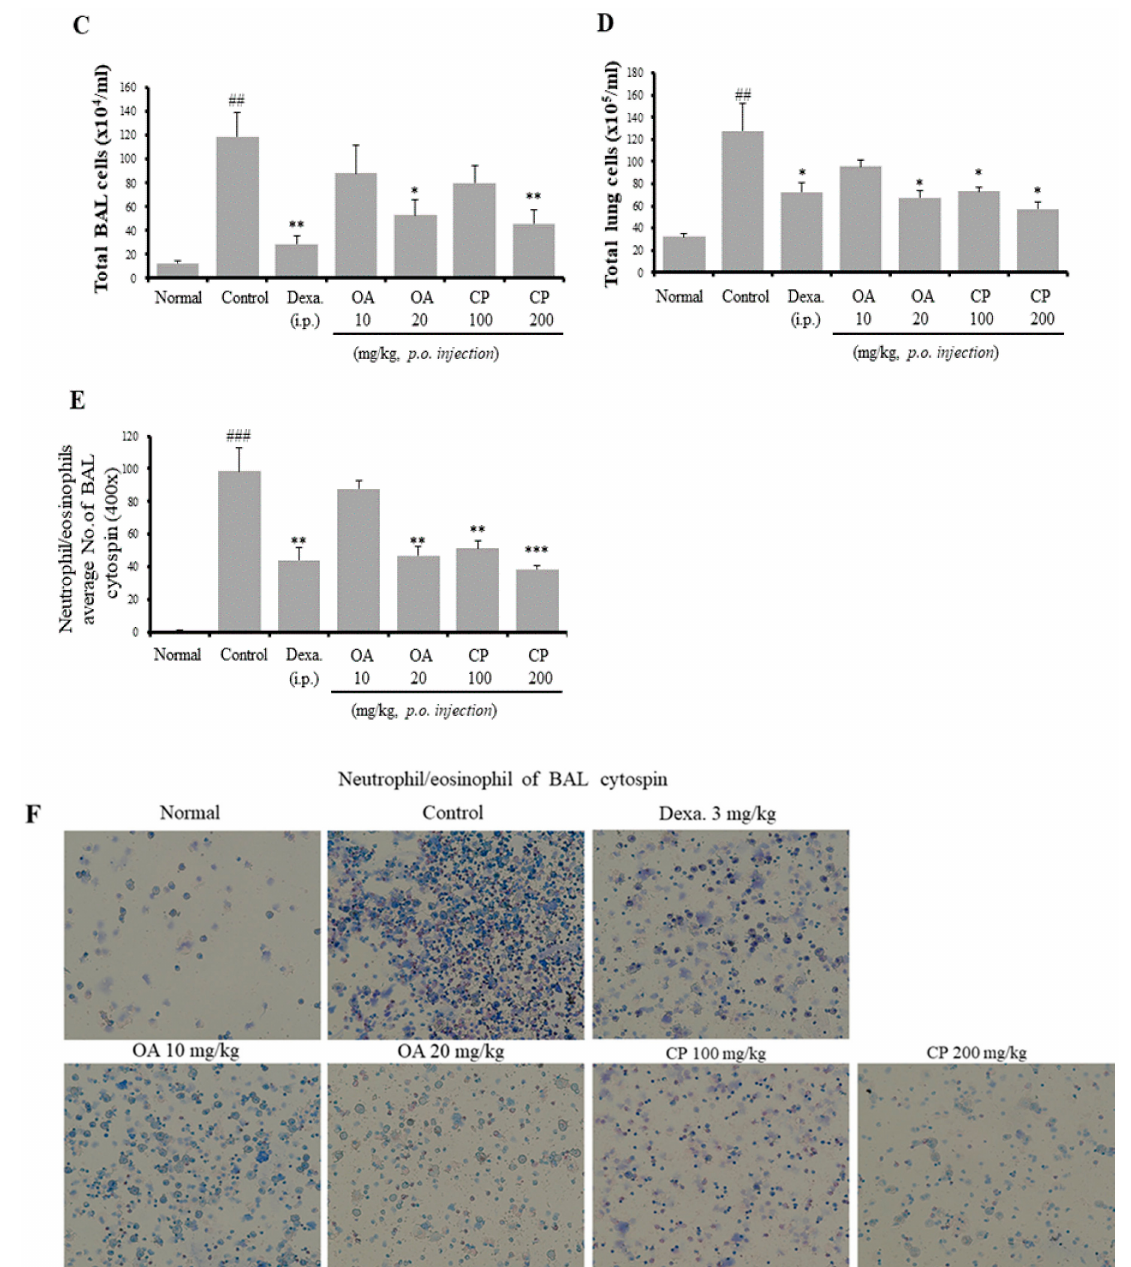
Figure 1. Schematic protocol illustration of ovalbumin (OVA)-induced mouse model of asthma ( A ). The suppressive effects of Cicadae Periostracum (CP) on airway hyperresponsiveness (AHR) in OVA-challenged mice were measured as enhanced pause (Penh) using non-invasive whole-body plethysmography ( B ). The effects of CP on total bronchoalveolar lavage fluid (BALF) cells ( C ), total lung cells ( D ), and neutrophils/eosinophils in BALF ( E ). BALF cytospin (400 × images of cytospin slide) in the OVA-induced mouse model of allergic asthma ( F ). Results are expressed as mean ± standard error of the mean (SEM; N = 6). * p < 0.05, ** p < 0.01, and *** p < 0.001 for the OVA control group versus the experimental group comparisons; # p < 0.05, ## p < 0.01, and ### p < 0.001 for the OVA control group versus the normal group comparison. Normal, Normal BALB/c mice; Control, OVA inhalation plus vehicle; Dexa., OVA inhalation plus dexamethasone, 3 mg/kg; OA, OVA inhalation plus OA, 10 and 20 mg/kg; CP, OVA inhalation plus CP (100 or 200